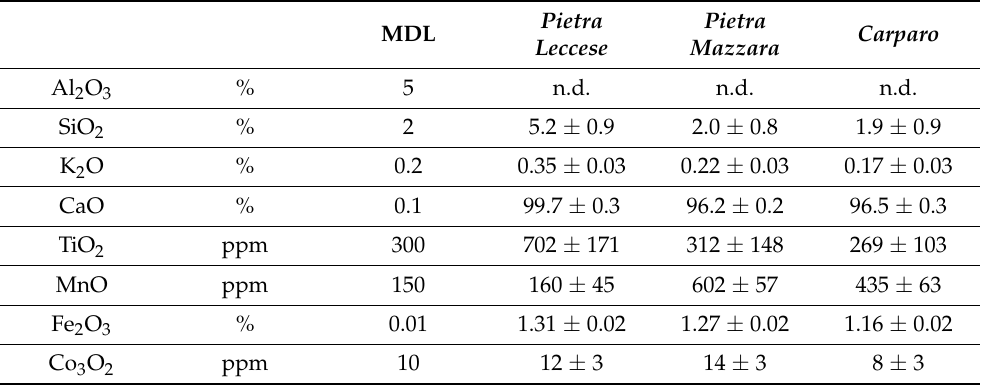
Table 1. Stones’ chemical composition: XRF